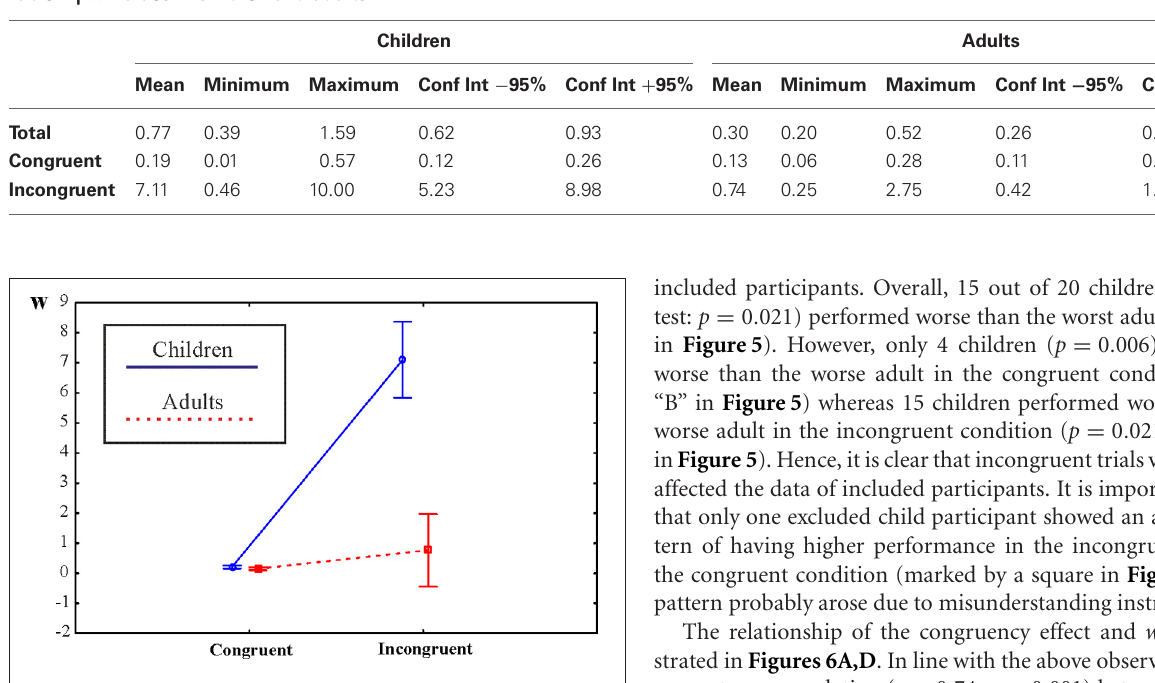
FIGURE 3 | Illustration of a Group × Congruency ANOVA on w- values. Ninety-five percentage confidence intervals are